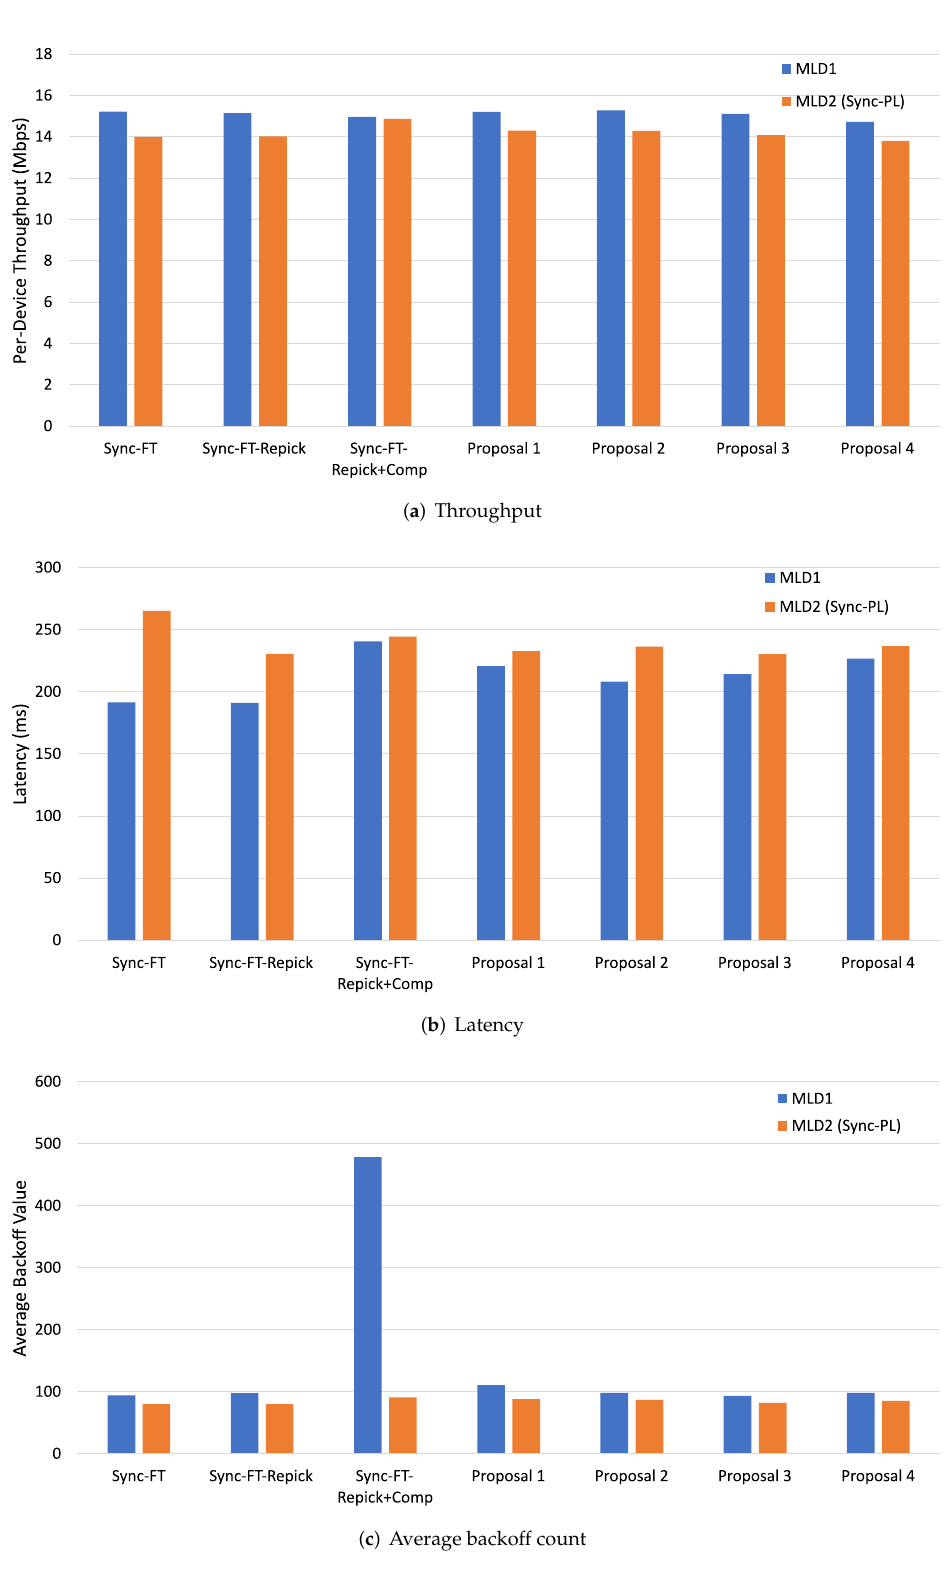
Figure 10. MLD vs. MLD performance in the 3GPP indoor deployment